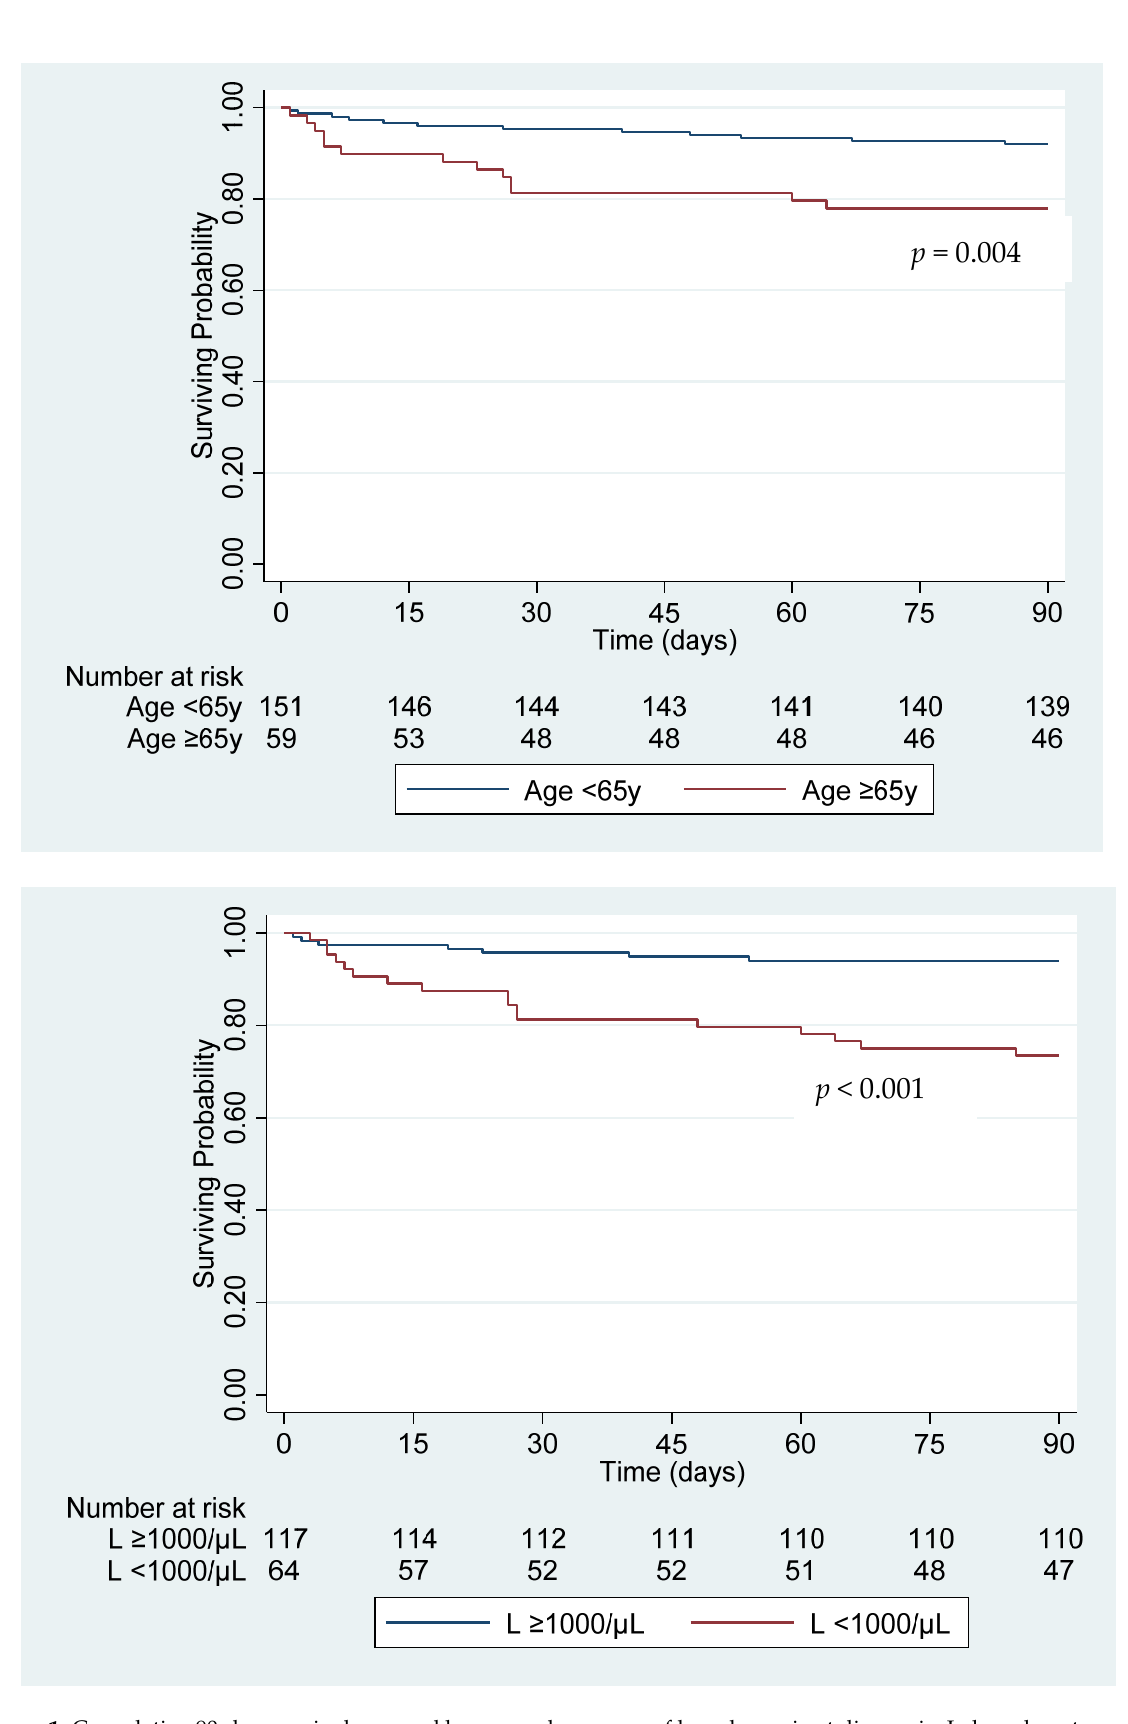
Figure 1. Cumulative 90 ‐ day survival grouped by age and presence of lymphopenia at diagnosis. L: lymphocyte count.